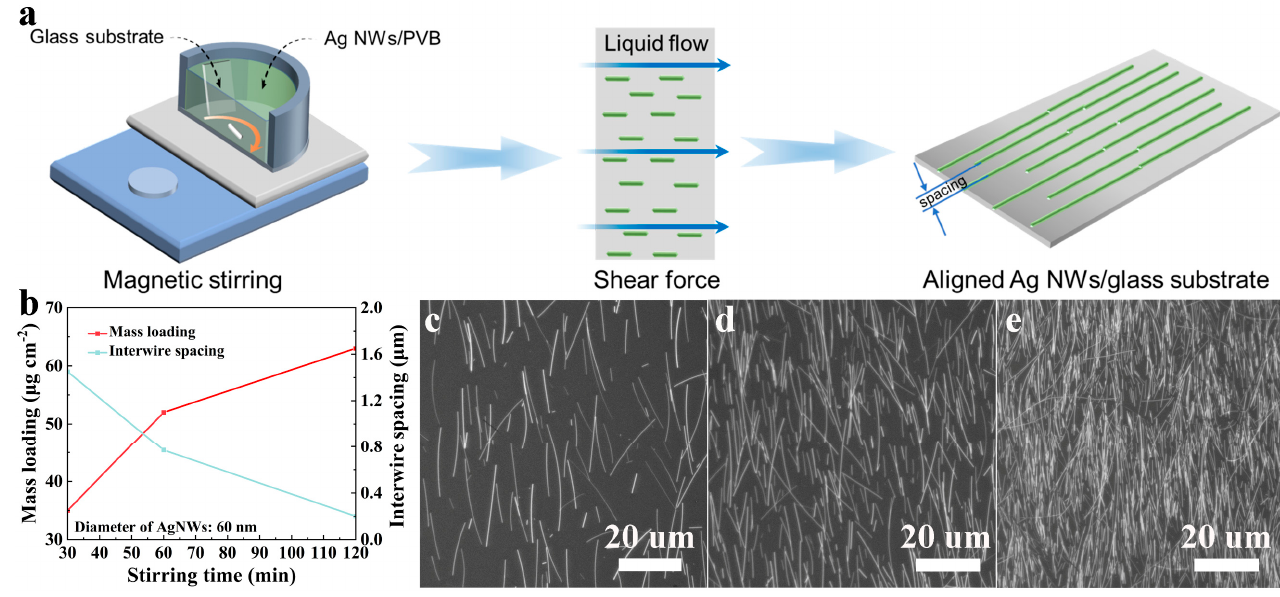
Figure 4. ( a ) Schematic illustration of stirring-assisted orientation alignment of Ag NWs. ( b ) Influence of the stirring duration on mass loading and interwire spacing of Ag NWs. SEM images of aligned Ag NWs with average interwire spacings of ( c ) 1.36 μ m, ( d ) 0.68 μ m, and ( e ) 0.28 μ m.